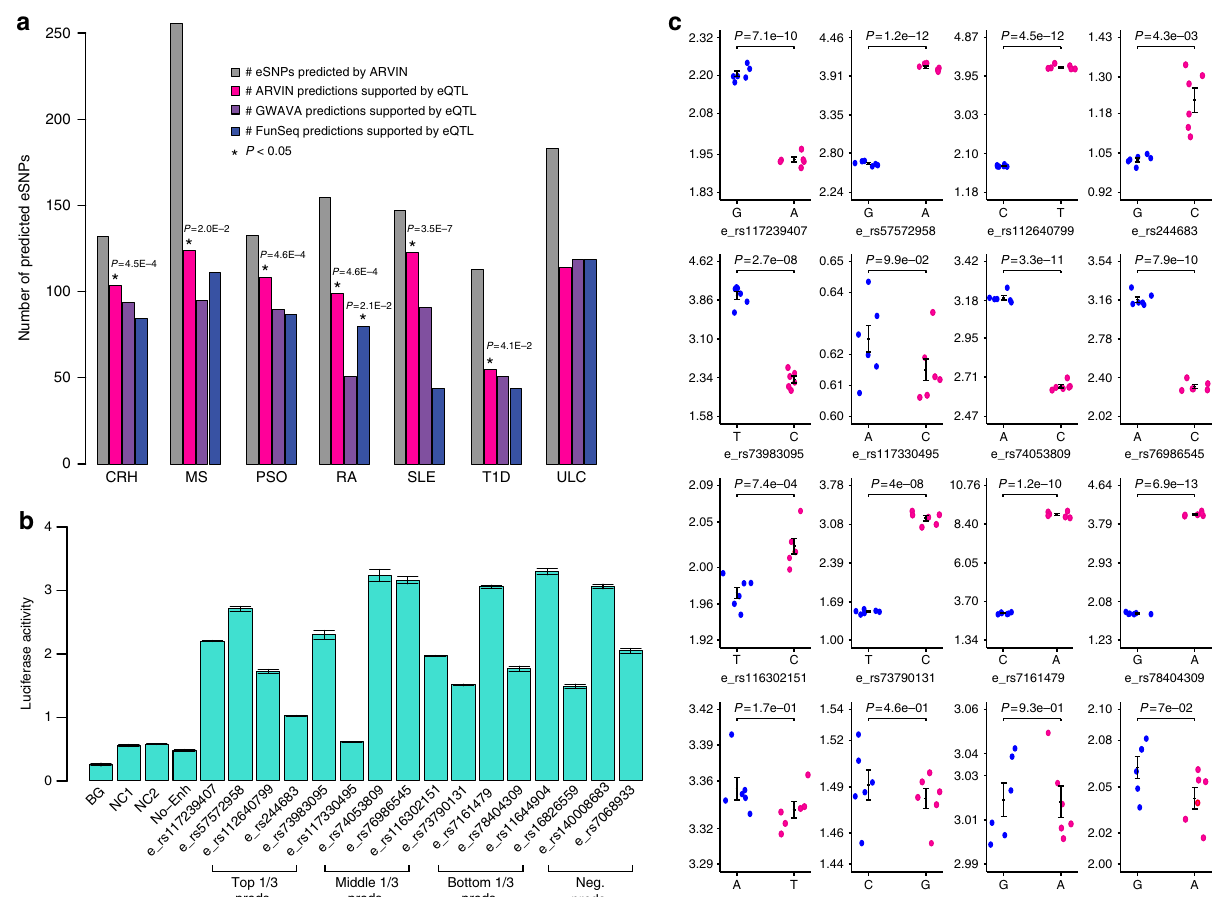
Fig. 4 Predicted risk enhancer SNPs in seven autoimmune diseases. a Number of predicted risk eSNPs in each disease and overlap with eQTL data. For comparison purpose, the prediction thresholds of GWAVA and FunSeq2 were set to give the same number of predictions as ARVIN. Statistical signi fi cance of overlap between predicted eSNPs by a given method and eQTL data were computed using the hypergeometric distribution. * P value < 0.05. CRH, Crohn ’ s disease; MS, multiple sclerosis; PSO, psoriasis; RA, rheumatoid arthritis; SLE, systemic lupus erythematosus; T1D, type 1 diabetes; ULC, ulcerative colitis. b Luciferase reporter assay of enhancers containing predicted risk eSNPs and negative control eSNPs. Reporter activity is relative to co-transfected Renilla control. BG, no DNA; NC1 & NC2, negative controls, genomic region without H3K4me1 and H3K27ac signals; No-Enh, construct containing only heat-shock (HS) promoter but no enhancer sequence; Top 1/3 pred., eSNPs in the top 1/3 of predictions by ARVIN, etc. Neg. pred., negative predictions by ARVIN. Values shown are means ± s.e.m. of six replicates. c Luciferase reporter activity for both alleles of 12 predicted risk eSNPs (top three rows) and 4 negative control (bottom row) eSNPs. Values shown are means ± s.e.m. of six replicates. P values are calculated using two-tailed t